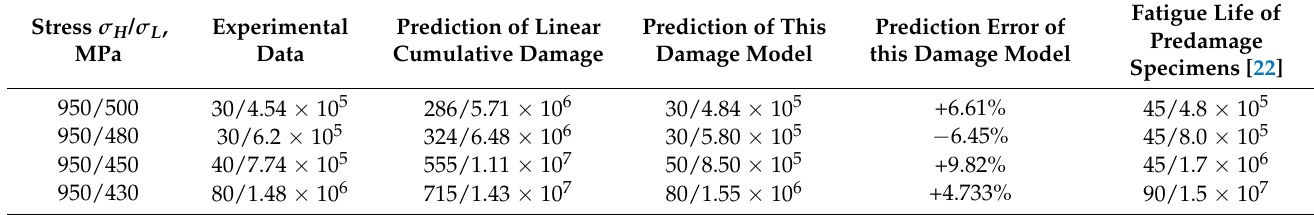
Table 1. Cumulative life under variable amplitude loading (cycle ratio: 10/2 × 10 5